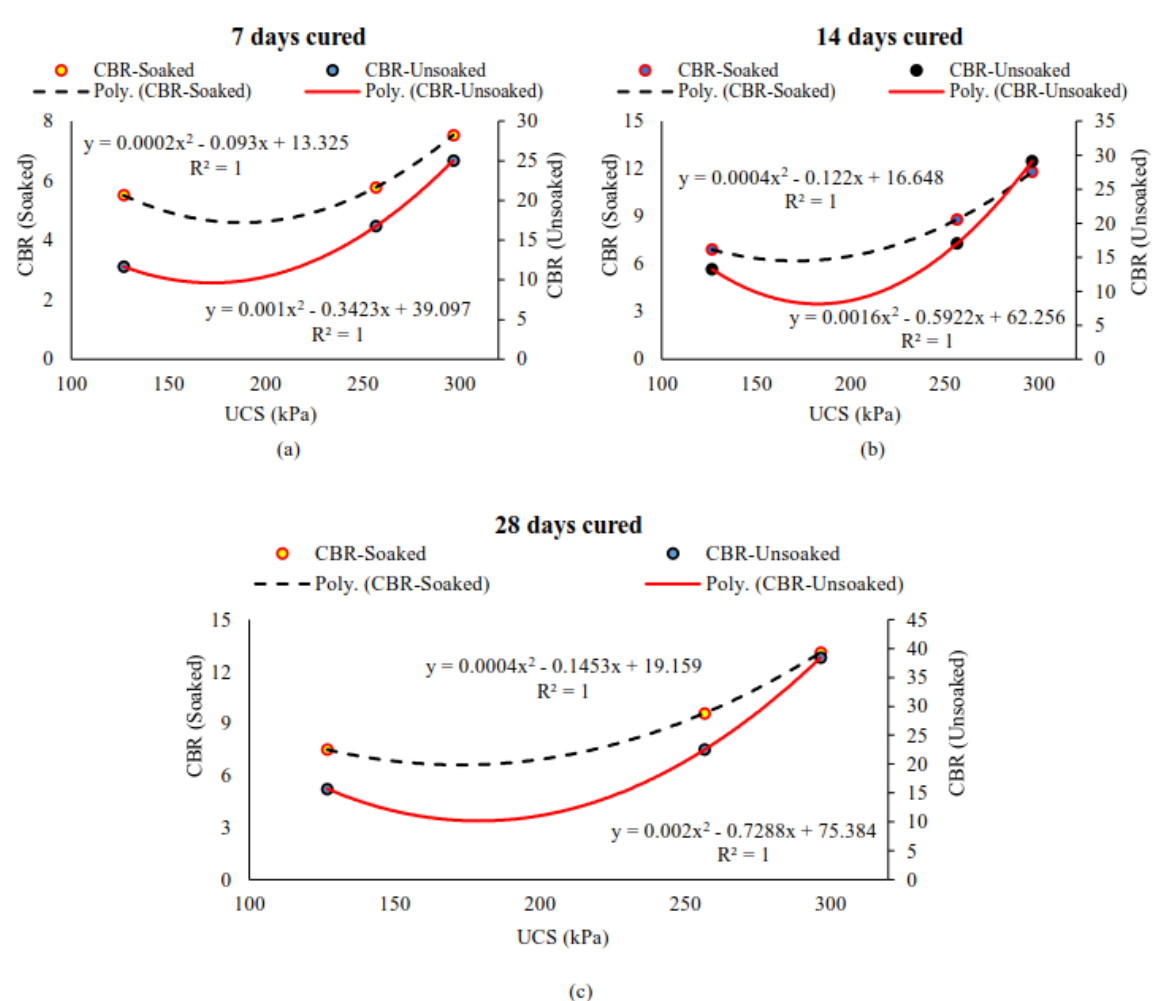
Figure 16. The statistical relationship between UCS and CBR (soaked and unsoaked) obtained after 7 ( a ), 14 ( b ), and 28 ( c ) days of curing. Table 7. Statistical analysis results for the verification of the variable similarity of CBR values (soaked and unsoaked) of 7, 14, and 28 days of curing.